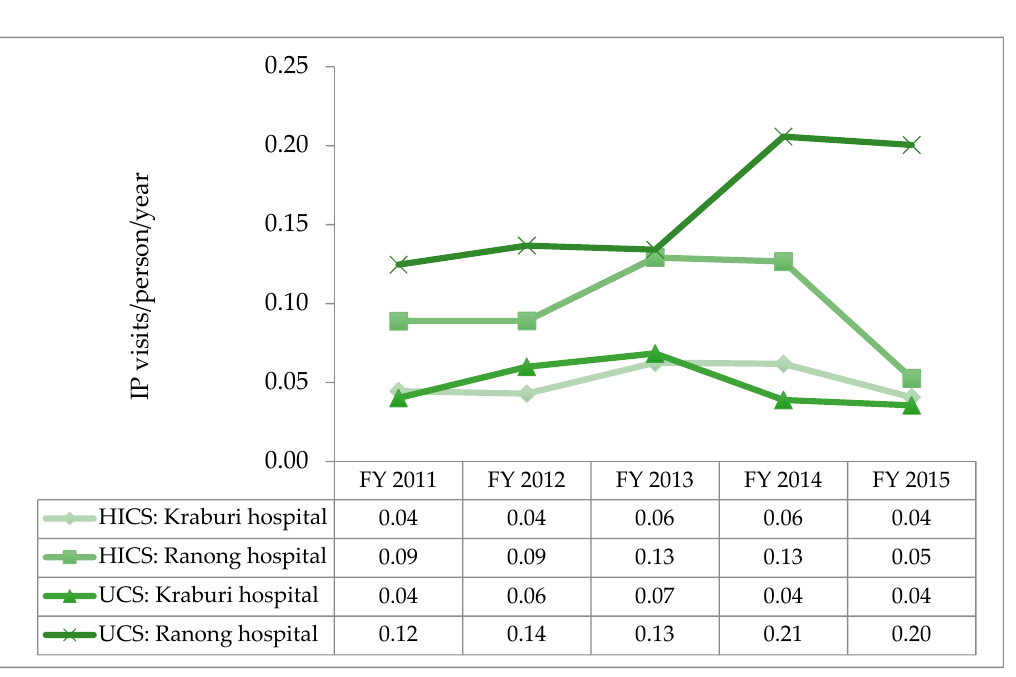
Table 1. Comparing total admissions by personal attributes and insurance schemes.